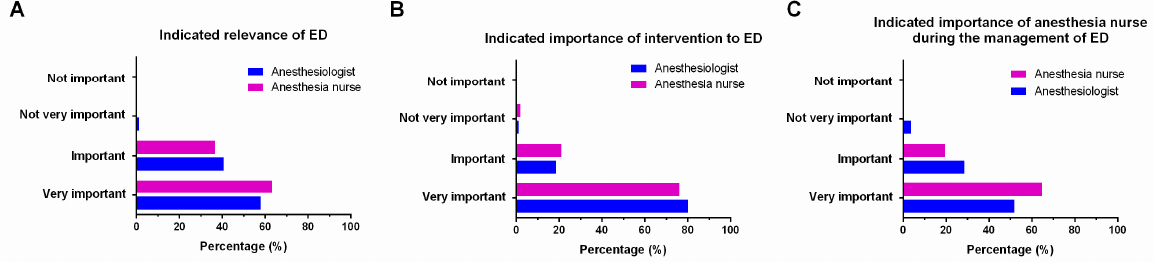
Figure 1. Importance of ED and ED-related issues reported by physicians and nurses,